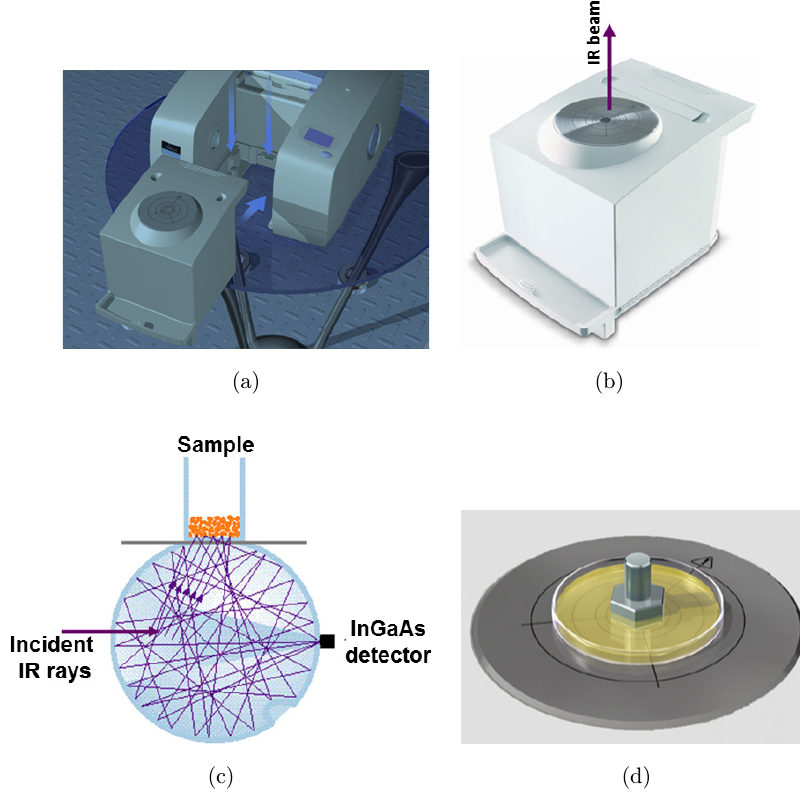
Fig. 1. FT-NIR spectrometer (Spectrum100N, PerkinElmer), (b) NIR re°ectance accessory (NIRA). Arrow: IR beam, (c) An integrating sphere; the sphere is covered with Barium Sul¯de with InGaAs detector and (d) NIRA liquid trans°ectance